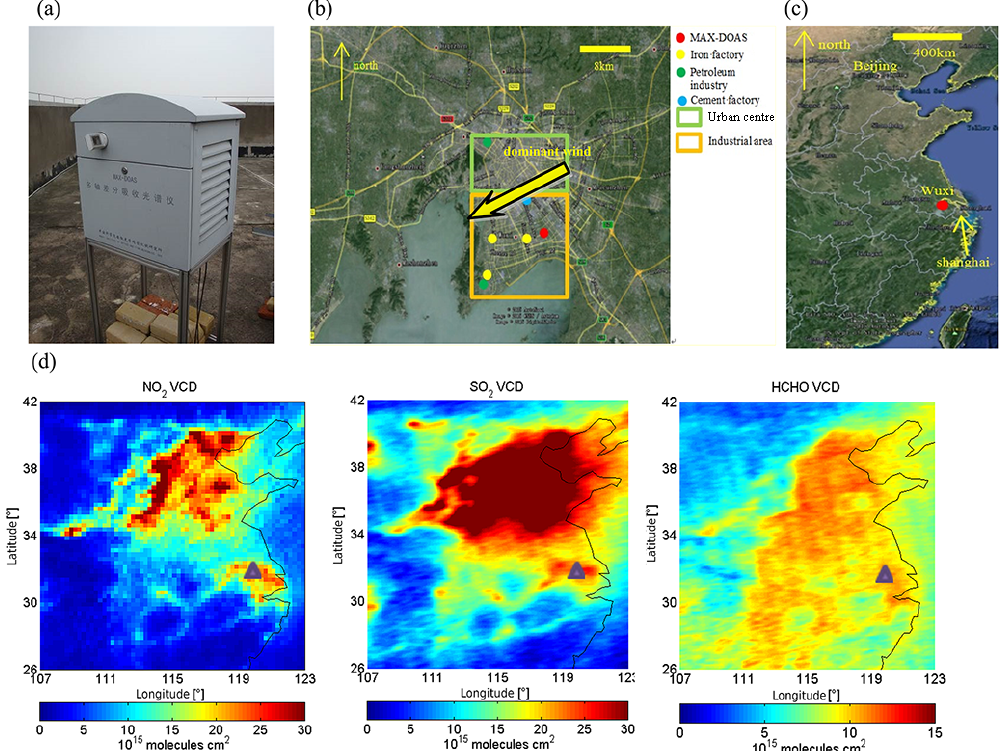
Figure 1. The MAX-DOAS instrument (a) (also the long-path DOAS and the visibility meter) is operated at the location marked by the red dot in (b) in Wuxi city (c) . In (b) , the dots with different colours indicate the positions of different types of emission sources; the green and orange blocks indicate the urban centre and industrial area, respectively. The yellow arrow represents the dominant wind direction (north- easterly wind). The maps of mean tropospheric VCDs of NO 2 (from DOMINO version 2), SO 2 (from BIRA, Theys et al., 2015) and HCHO (from BIRA, De Smedt et al., 2015) derived from OMI observations over eastern China in the period from 2011 to 2014 are shown in (d) , in which the triangles indicate the location of